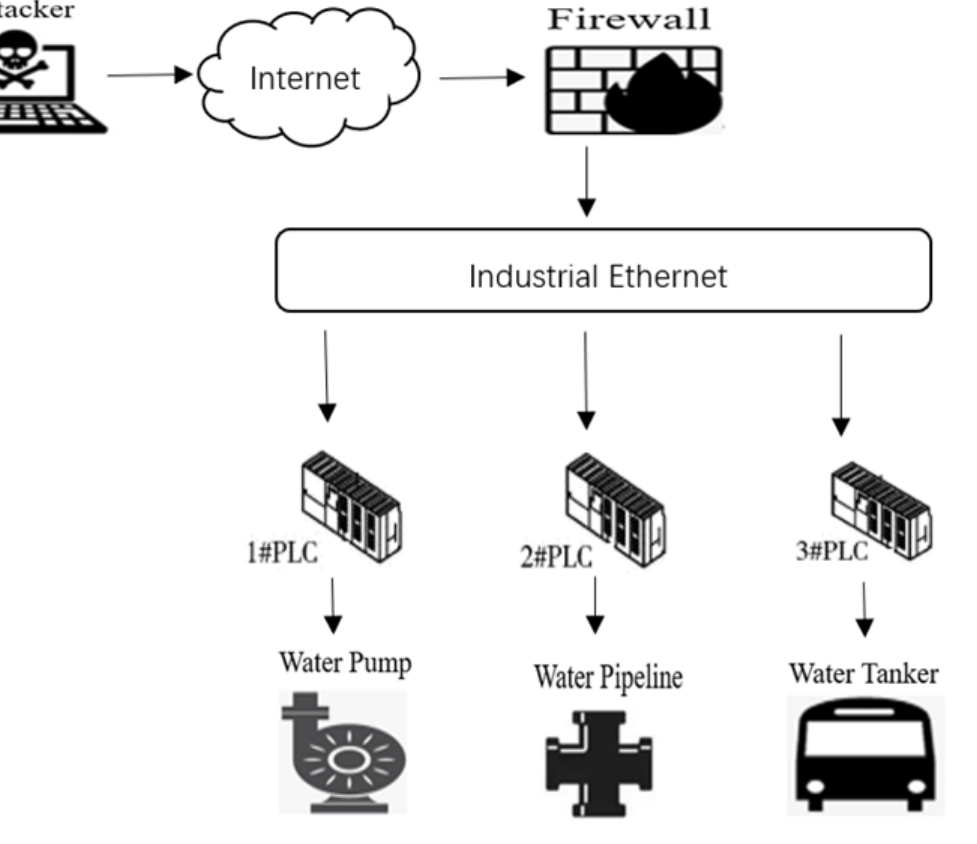
Figure 3. Experimental scene.